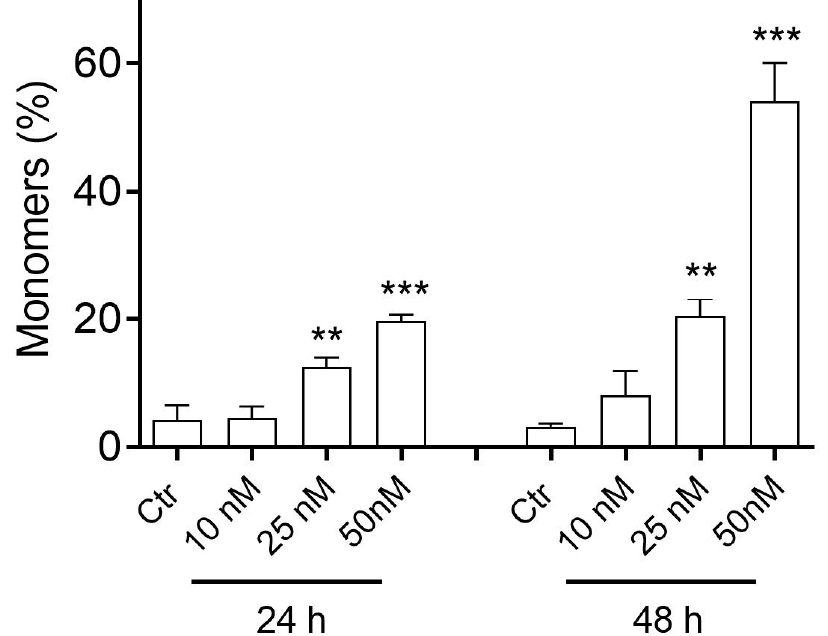
Figure 6. Assessment of mitochondrial depolarization after treatment with 3d . HeLa cells were treated with the indicated concentrations of compound for 24 or 48 h. Data are represented as mean ± SEM of three independent experiments (** p < 0.01, *** p < 0.001).